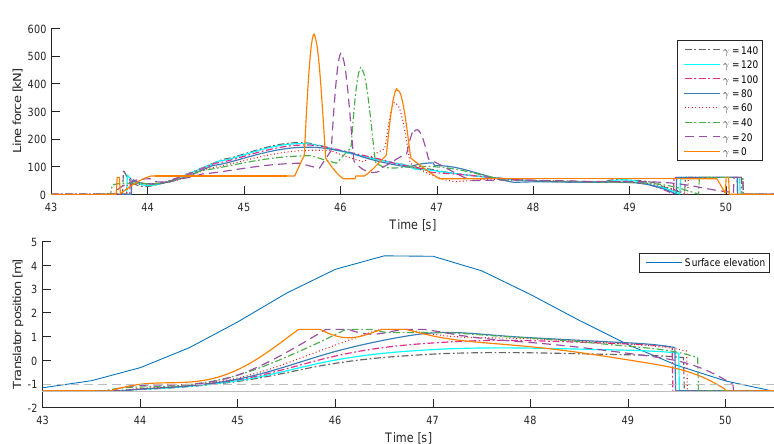
Figure 12. The line force and the translator position when the WEC is impacted by a high periodic wave, comparing the influence of generator damping factor γ . Increasing the generator damping decreases the force of the endstop hits. For γ = 80 kNs/m or higher, endstop hits were prevented.